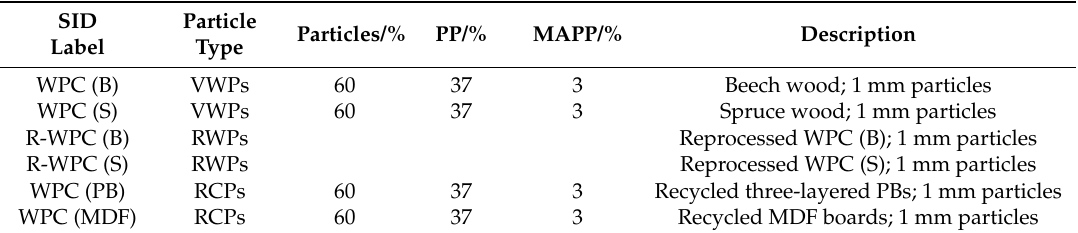
Table 1. Composition of WPC formulations. SID: sample identification; VWPs: virgin wood particles; RWPs: reprocessed WPC particles; RCPs: recycled composite